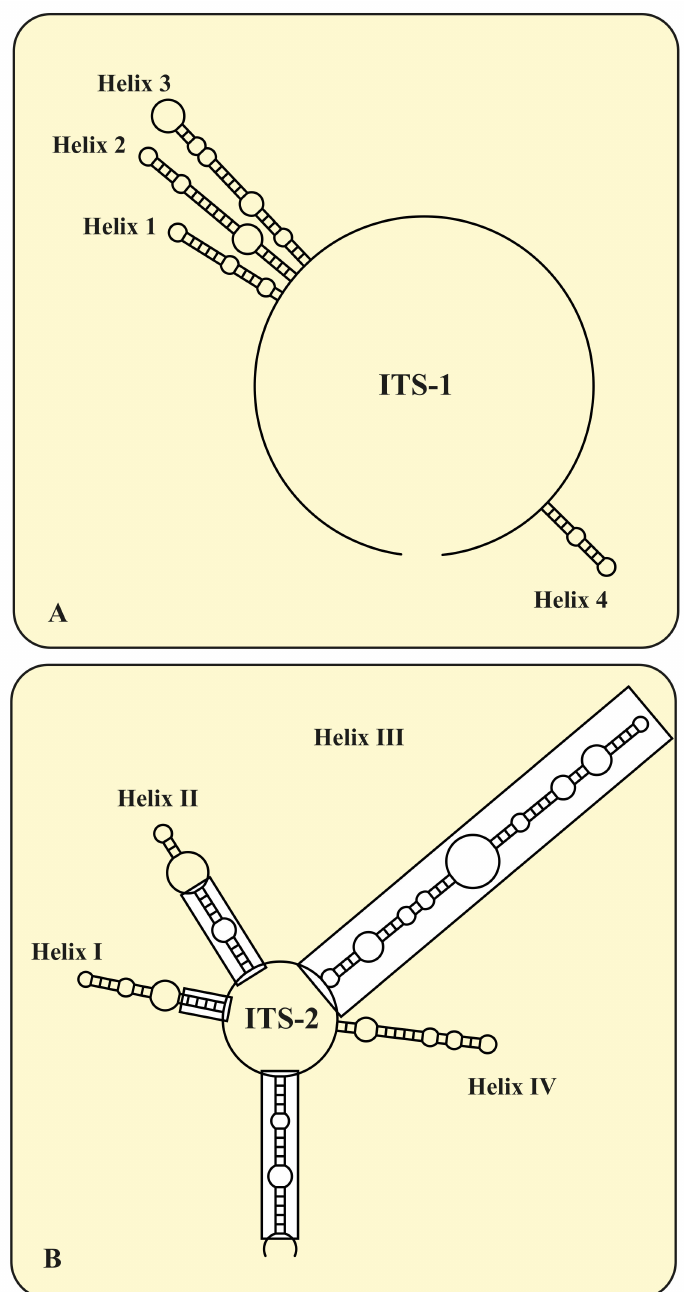
Figure 4. Secondary structure of the V9 region (Helix 49) of the SSU rDNA among the Micractinium species. The variable region within the V9 are highlighted in white